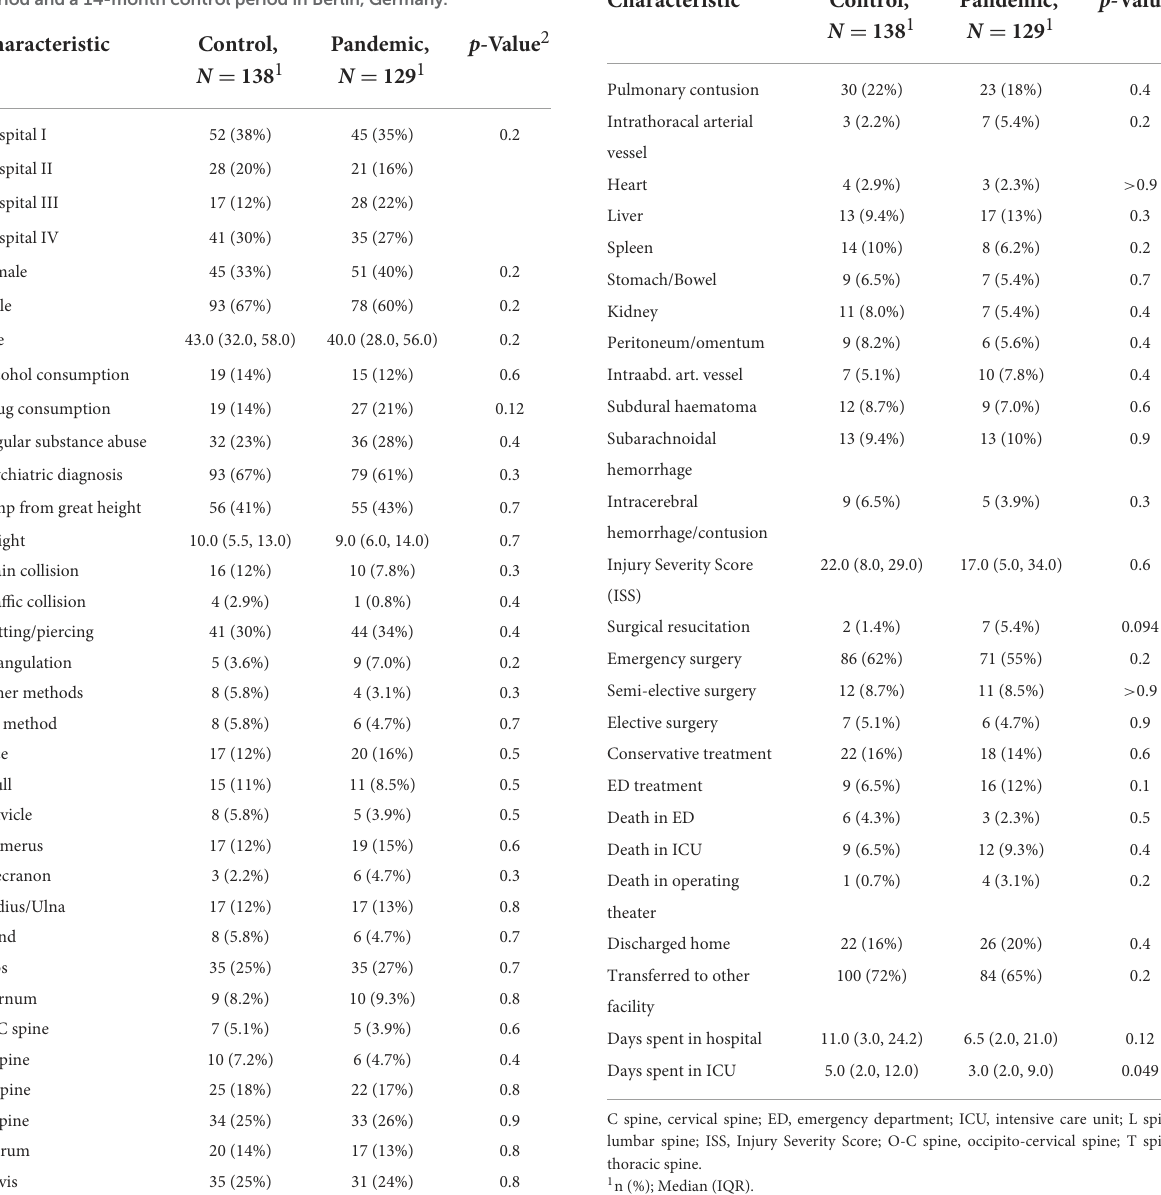
TABLE 1 Characteristics of patients who committed serious violent suicide attempts (SVSAs) during a 14-month COVID-19 pandemic period and a 14-month control period in Berlin,